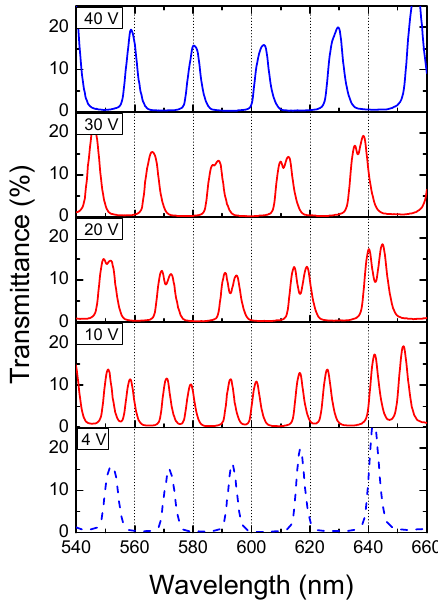
Figure 4. Transmission spectra of the PC/CD-DFLC cell in the dynamic mode.